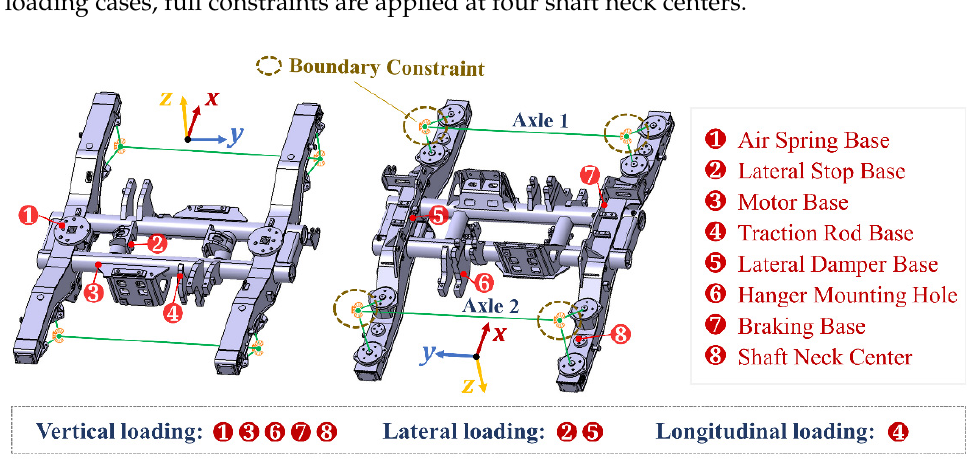
Figure 3. Load coupling reference point. Table 3. Load case summary. Load Case